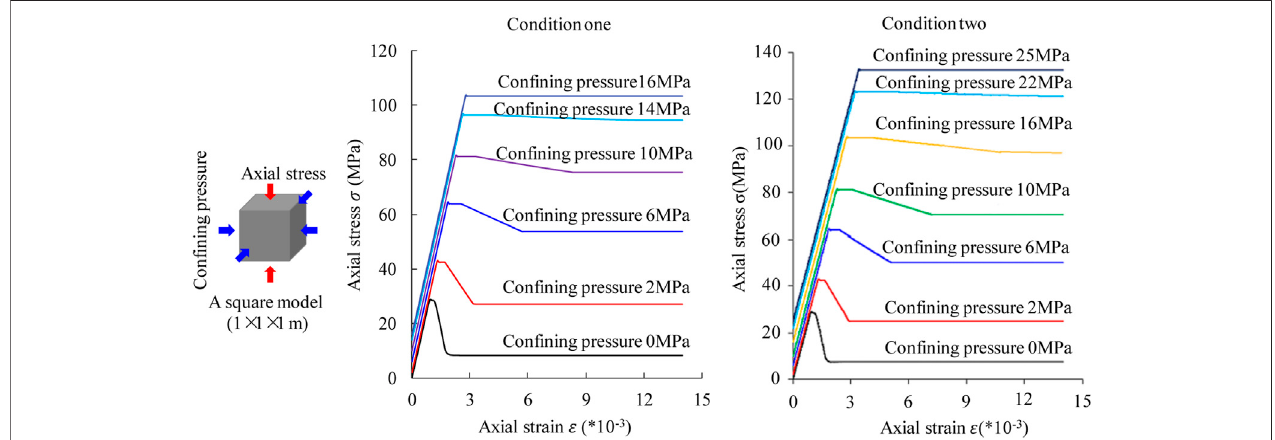
FIGURE 6 | Axial stress-strain curves under different conditions.